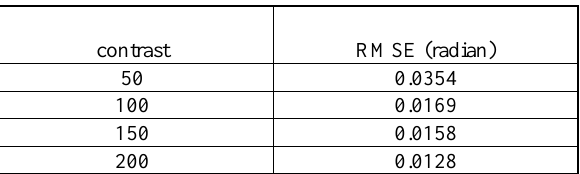
Table 3. Phase error due to different lighting condition.